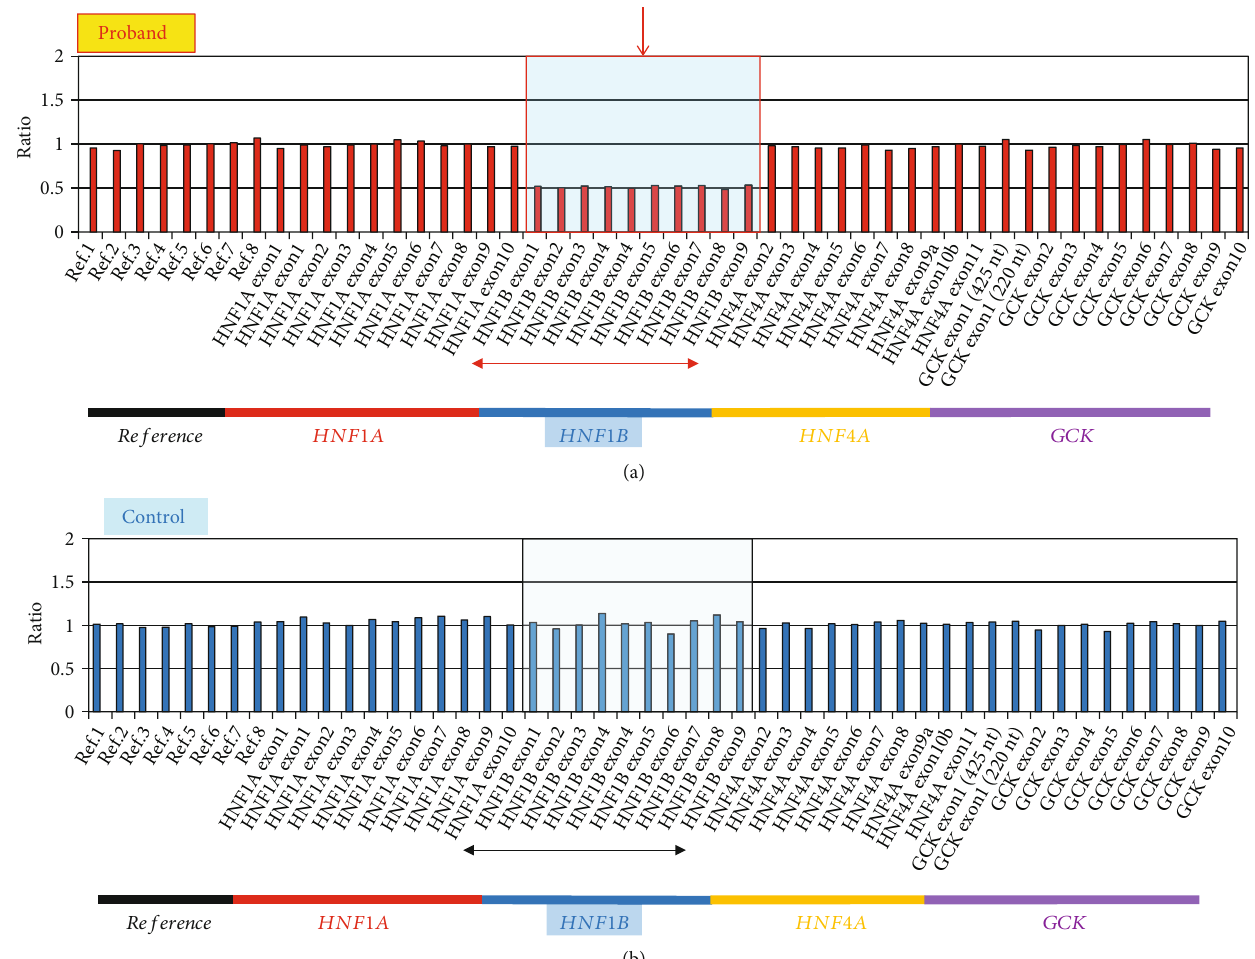
Figure 2: Detection of a whole hemizygous deletion in the HNF1 β gene in leukocyte genomic DNA by MLPA assay. Graphical representation of the HNF1 β gene. Chromosome X and Y probes were normalized to the control in the proband (a) and control (b). MLPA results show that all HNF1 β probes are expressed in half dosages in the proband relative to the expected heights indicating a whole-gene hemizygous deletion change in HNF1 β . The whole-gene deletion of HNF1 β is marked with a red arrow and